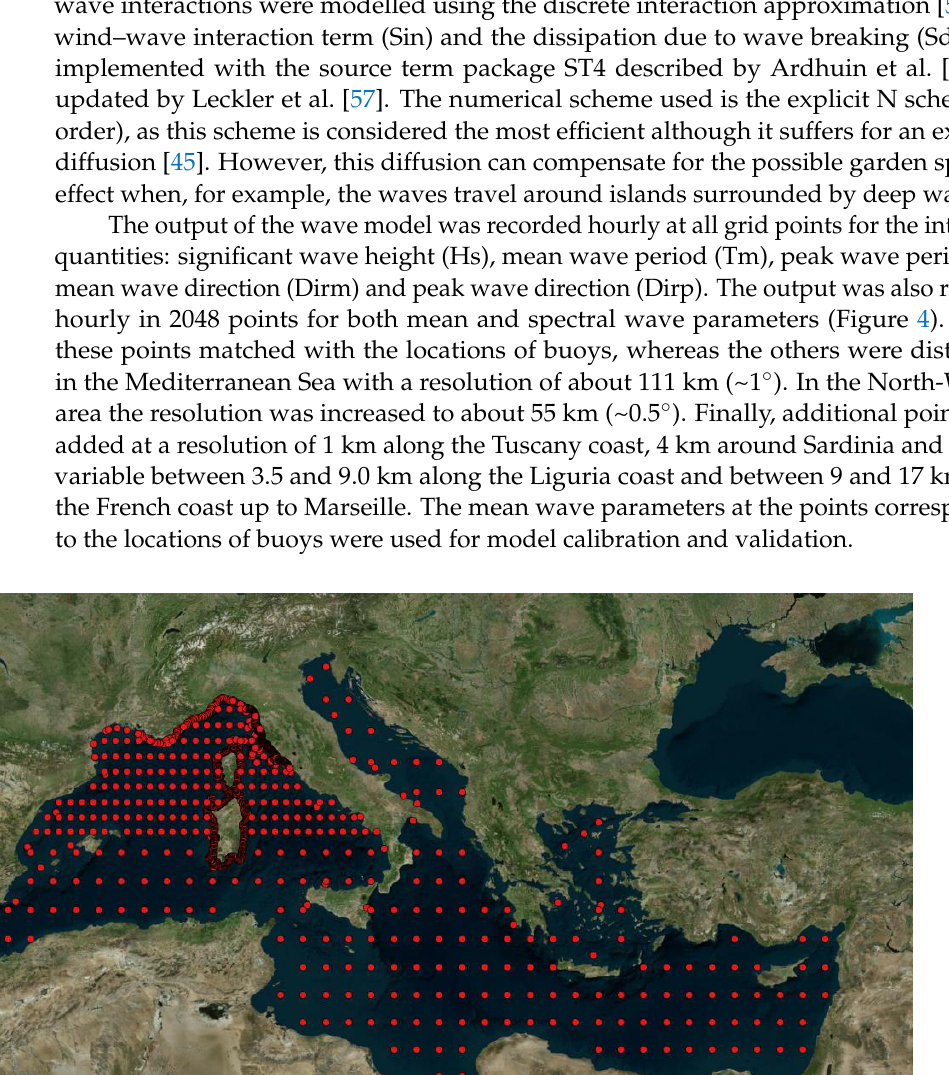
Figure 3. Extent of the WaveWatch III (WW3) domain with enlarged views of North-Western Mediterranean Sea (light blue box) and Tuscany Archipelago and Eastern Ligurian Coast (red box).